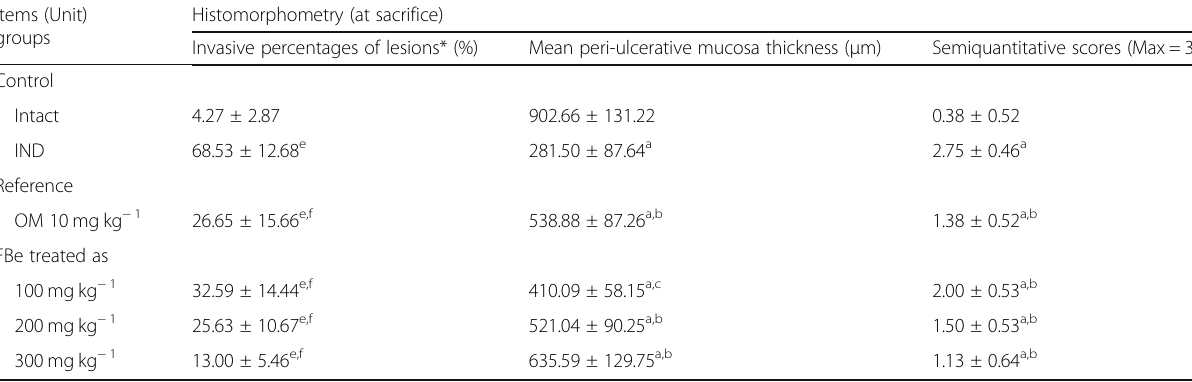
Table 3 Histomorphometrical analysis on the fundus, taken from intact or IND-treated rats Items (Unit)